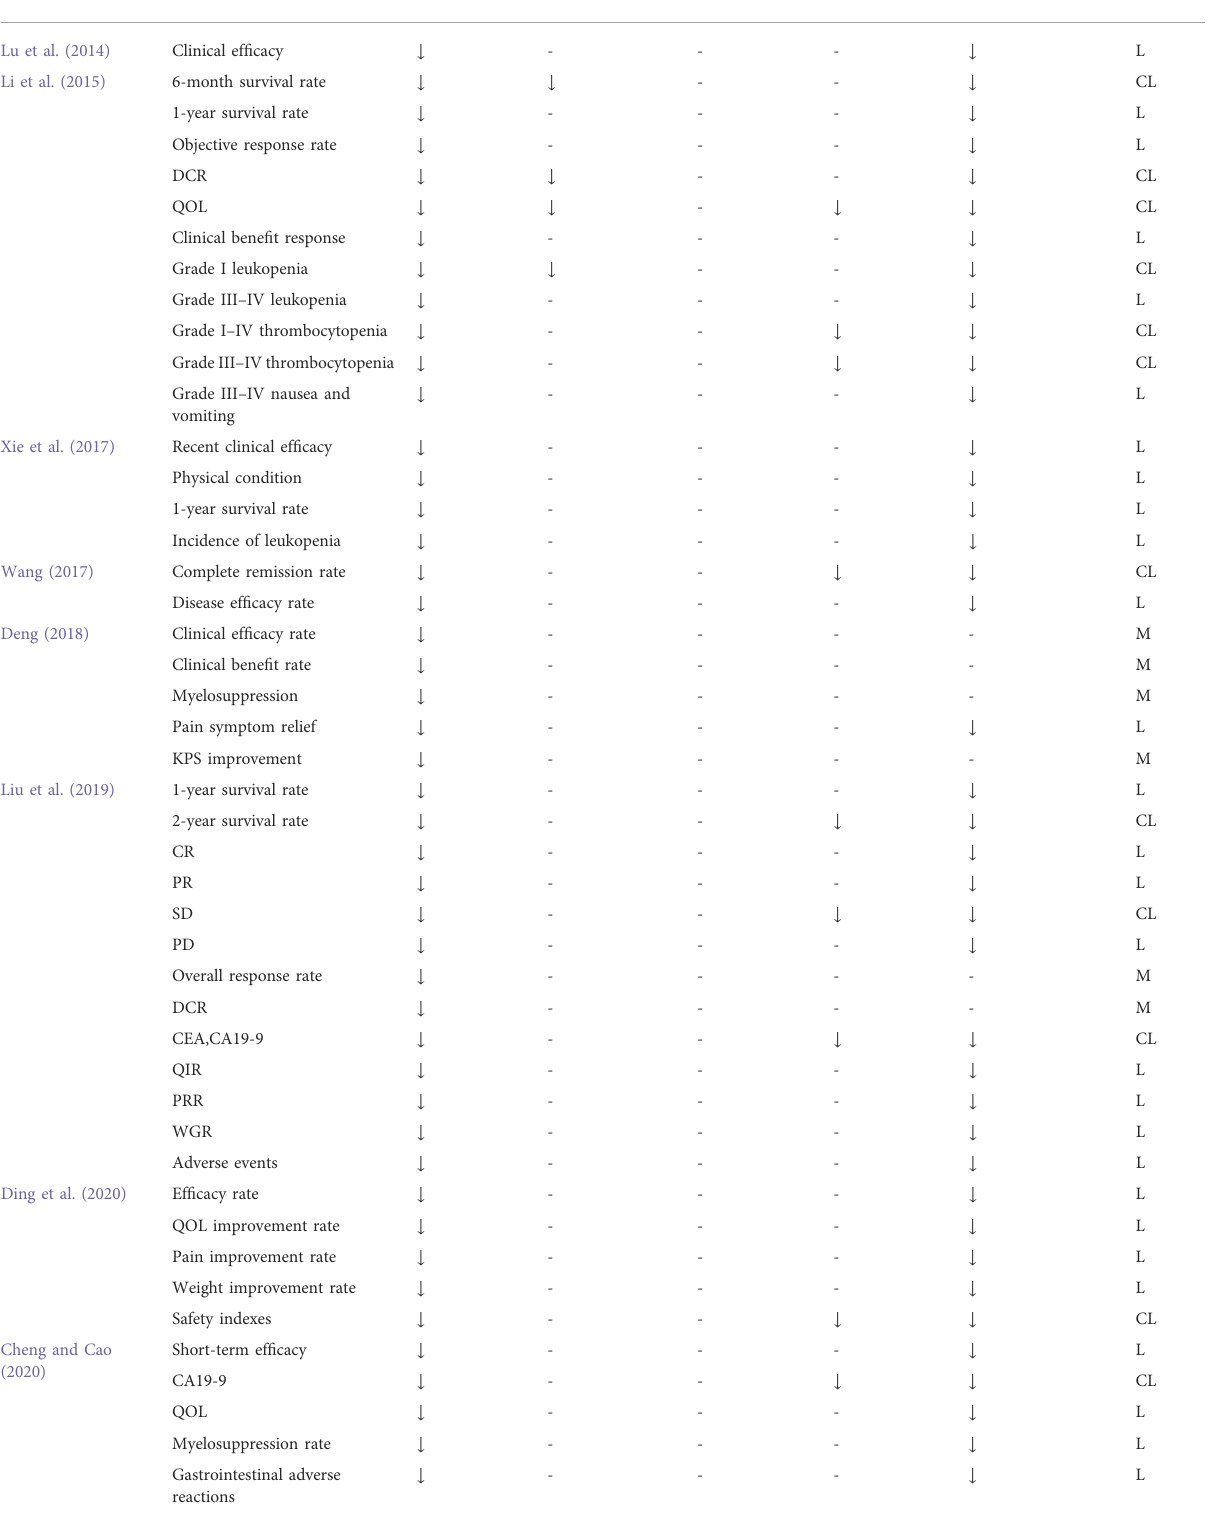
TABLE 3 GRADE evaluation